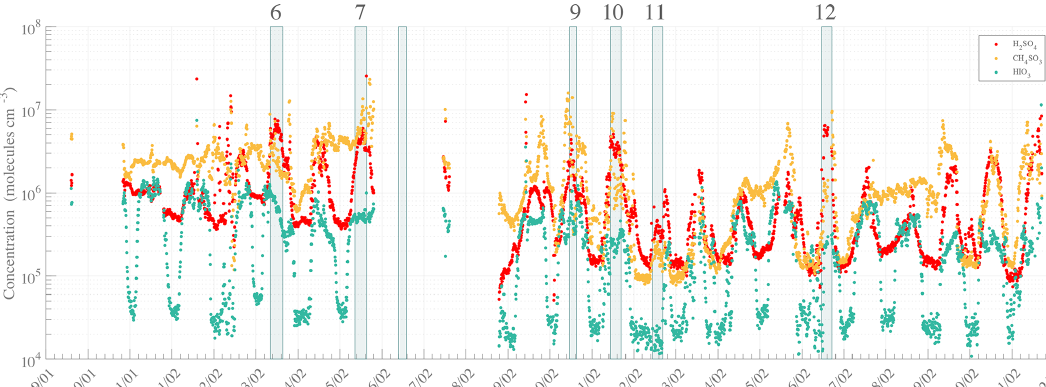
Figure 4. High-resolution time series of H 2 SO 4 (SA, red), CH 4 SO 3 (MSA, orange), and HIO 3 (IA, green). Numbers specified at the top of the figure refer to the event number as introduced into the NPF analysis (see Table 1). The data are averaged to 10min with local time (UTC − 3). Note that the missing points are due to a switch in the measurement mode and/or data availability.